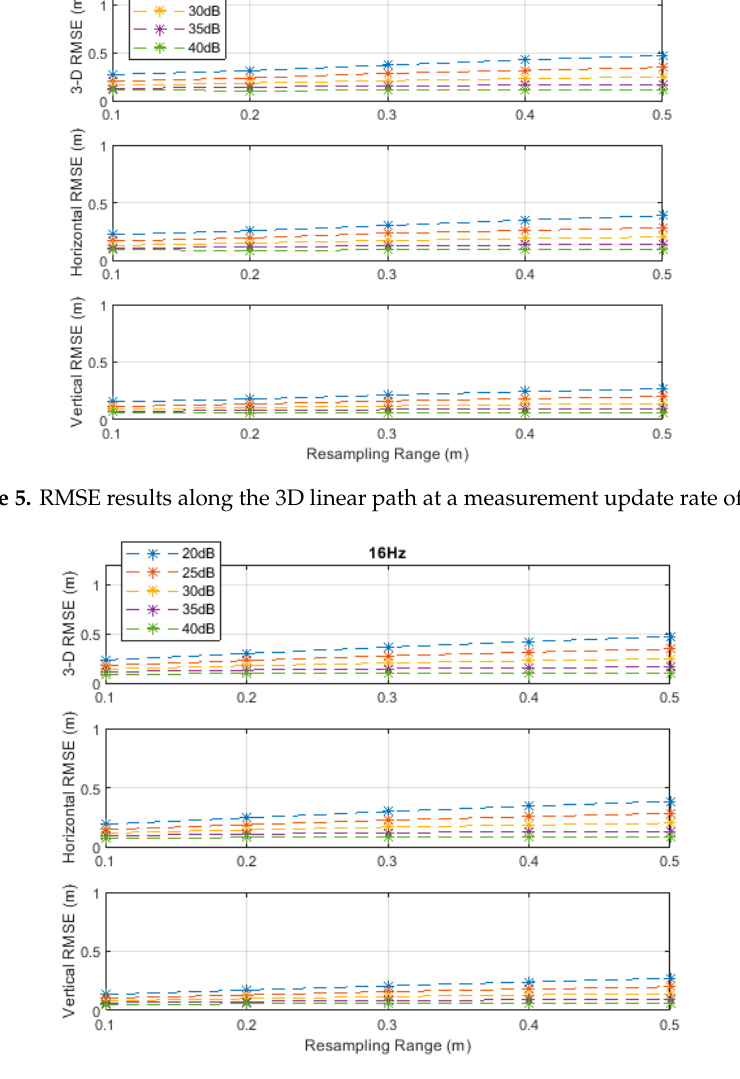
Figure 6. RMSE results along the 3D linear path at a measurement update rate of 16 Hz.